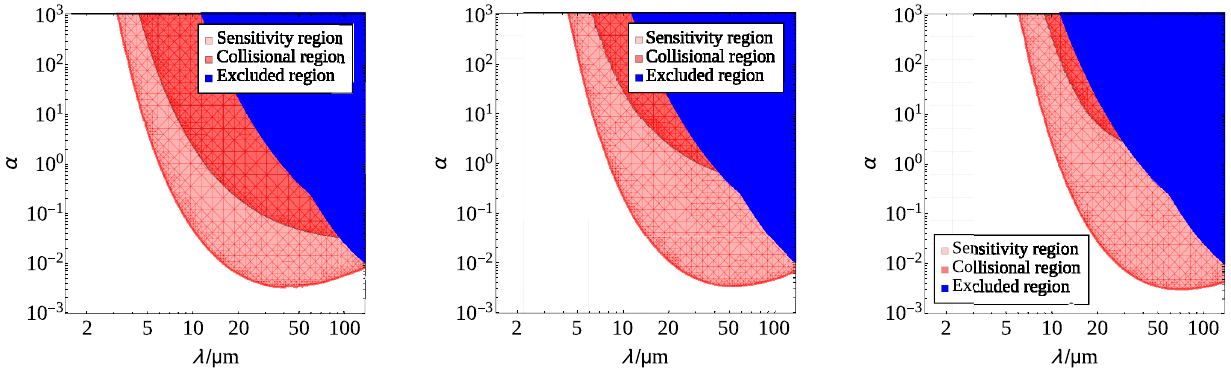
Fig. 7 Variation of the size of the collisional region (meshed red) panel: r 0 = 177 . 7 μ m, ˙ r 0 = 13 . 4 nm s − 1 and ˙ θ 0 = 259 . 3 μ rad s − 1 within the region of the parameter space that can be tested with the ( r a ∼ 200 μ m and r p ∼ 100 μ m). The blue region is the area of the proposed setup (pink) as a function of the initial conditions. Left panel: r 0 = 111 . 8 μ m, ˙ r 0 = 30 . 6 nm s − 1 and ˙ θ 0 = 491 . 1 μ rad s − 1 (corresponding to r a ∼ 150 μ m); Middle panel: r 0 = 138 . 7 μ m, ˙ r = 13 . 4 nm s − 1 and ˙ θ = 363 . 5 μ rad s − 1 ( r ∼ 160 μ m); Right 0 0 a